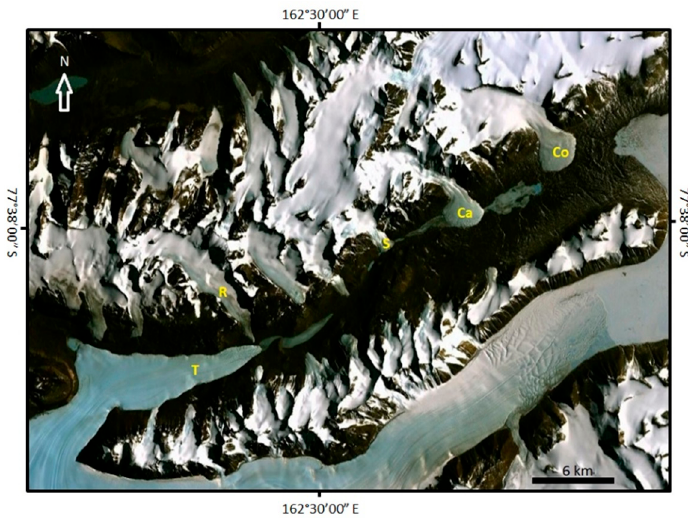
Figure 1. Taylor Valley, Antarctica, with Commonwealth (Co), Canada (Ca), Suess (S), Rhone (R), and Taylor (T) Glaciers indicated. The image was retrieved from the online Earth Explorer, courtesy of the NASA EOSDIS Land Processes Distributed Active Archive Center (LP DAAC), USGS/Earth Resources Observation and Science (EROS) Center, Sioux Falls, South Dakota, https://earthexplorer.usgs.gov/.